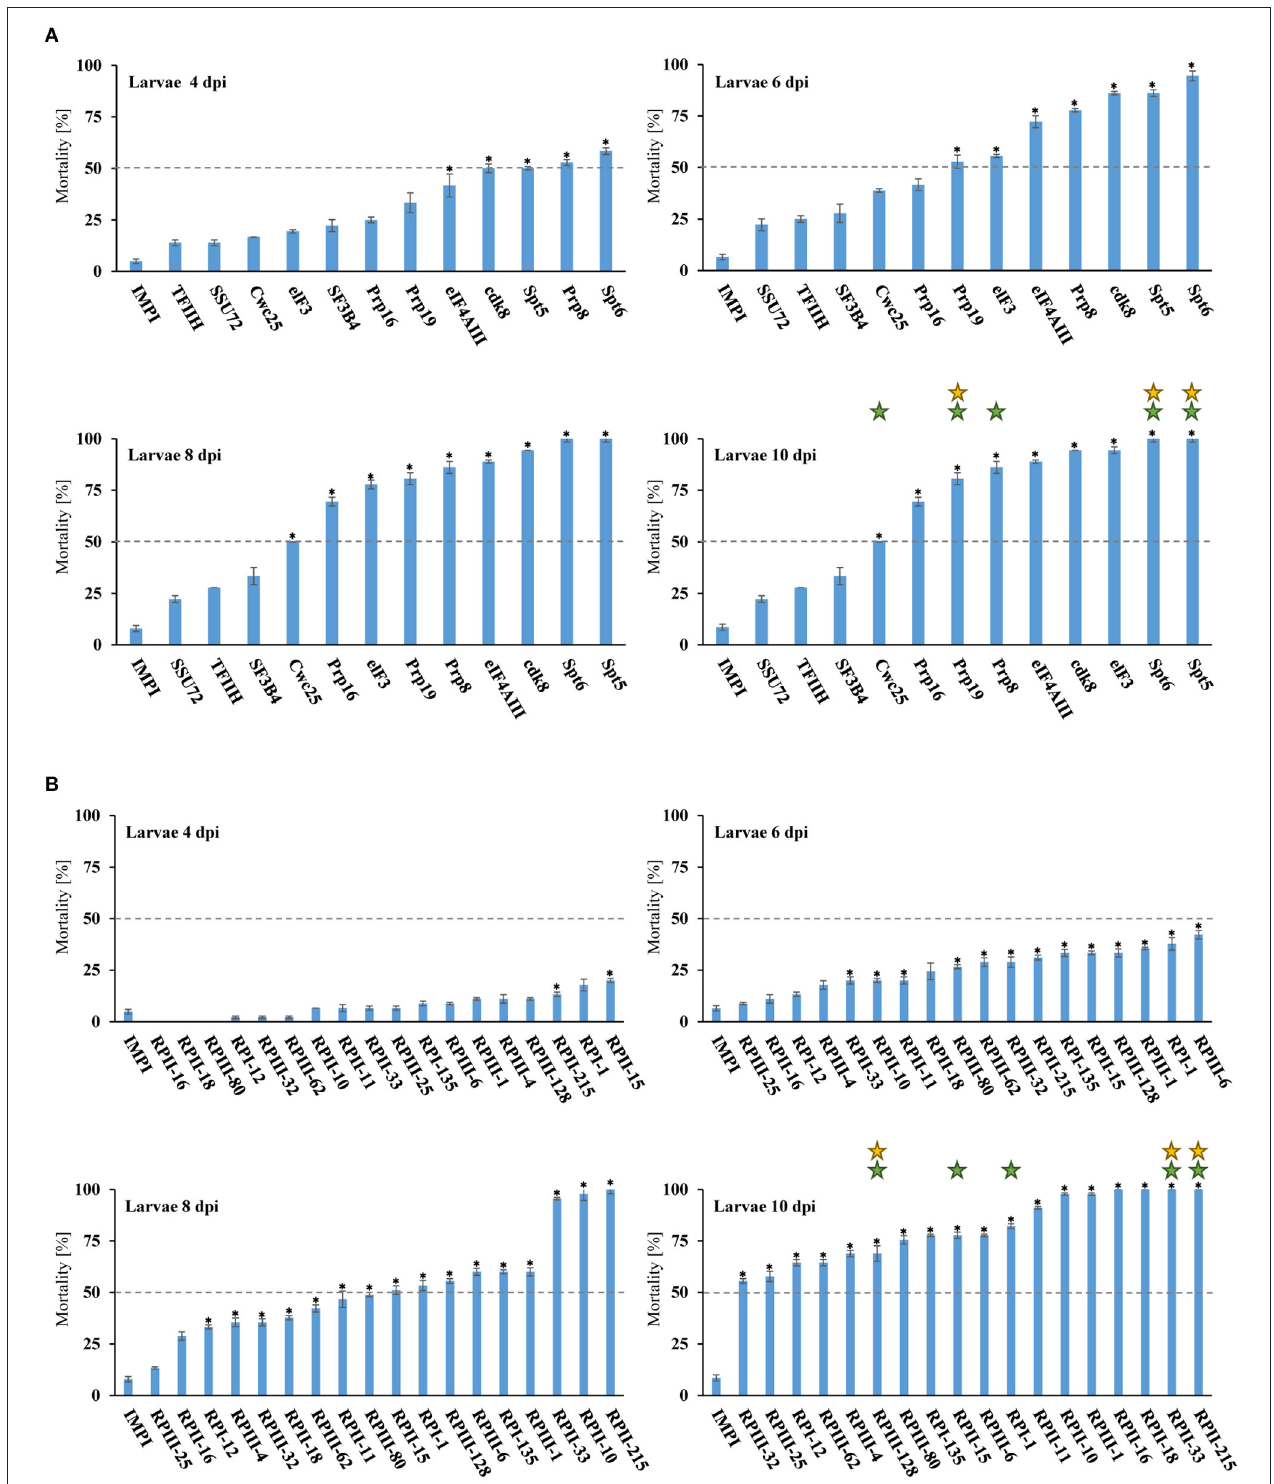
FIGURE 2 | Mortality rates of T. castaneum larvae after knockdown. Injection of 150 nl of dsRNA [250 ng/ µ l] targeting genes involved in the process of transcription (A) and different RNA polymerase subsunits (B) into T. castaneum larvae. Mortality rates were tracked every 48h for 10 days. The G. mellonella gene IMPI was used as negative control. The data represent three biological replicates ( n = 15 for each replicate). Asterisks show statistical difference ( p < 0.001). Green stars represents selected D. v. virgifera and yellow B. aeneus orthologs. The results were analyzed with analysis of variance (ANOVA) ( Supplementary Table 1 ).